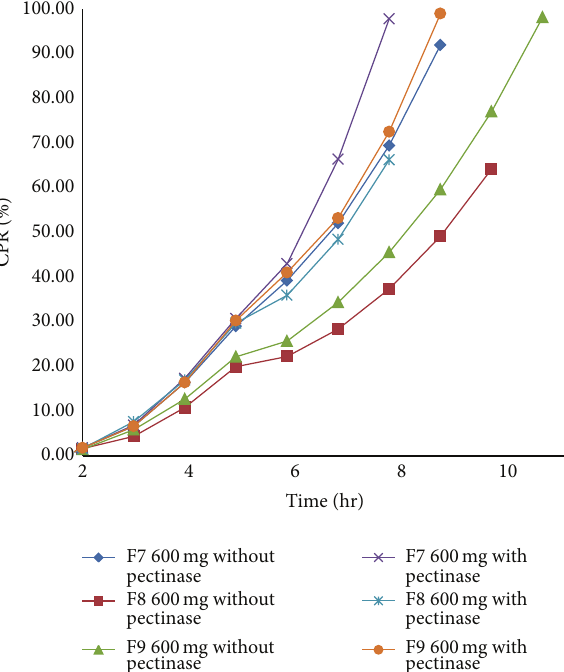
Figure 3: In vitro dissolution profile of batch F7 to F9 with and without pectinase